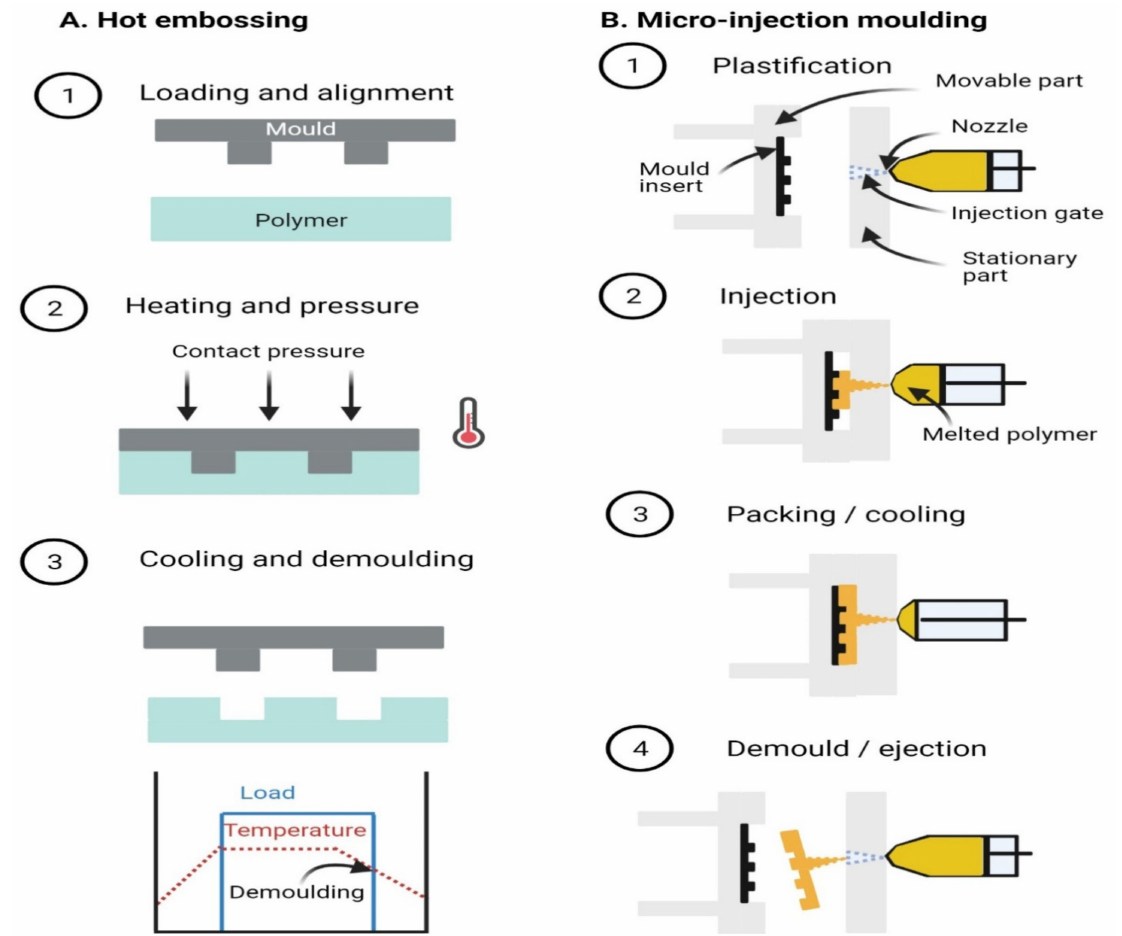
Figure 6. Schematic for ( A ) hot embossing and ( B ) micro-injection